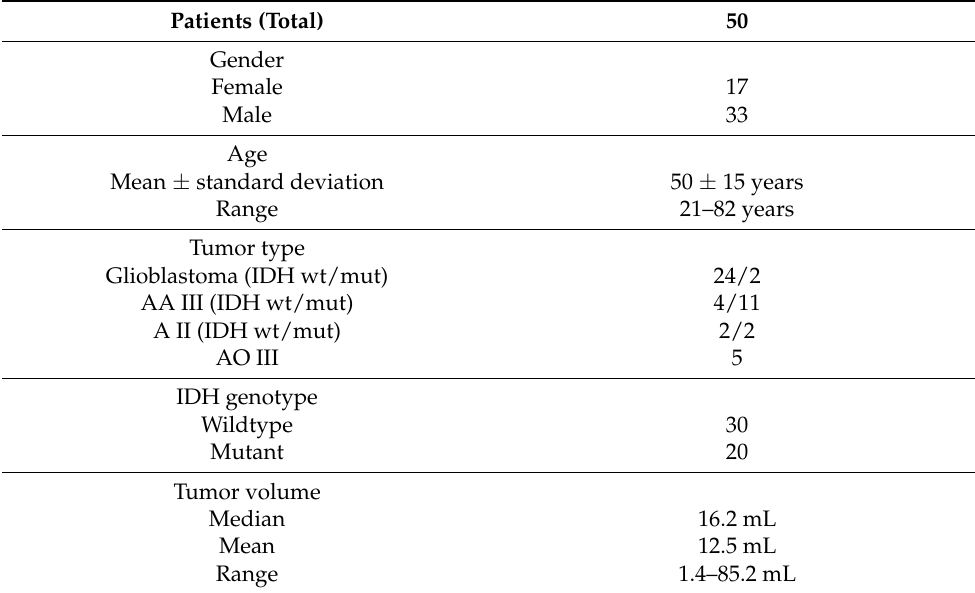
Table 1. Patients